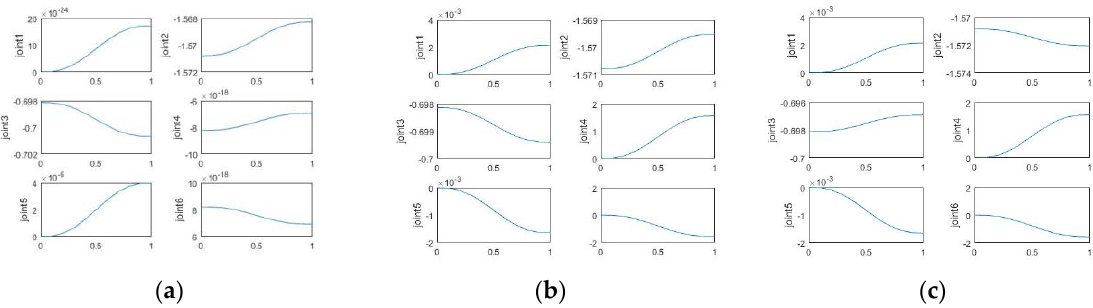
Figure 6. ( a ) The change of each joint in serial 1, ( b ) the change of each joint in serial 2, and ( c ) the change of each joint in serial 3.